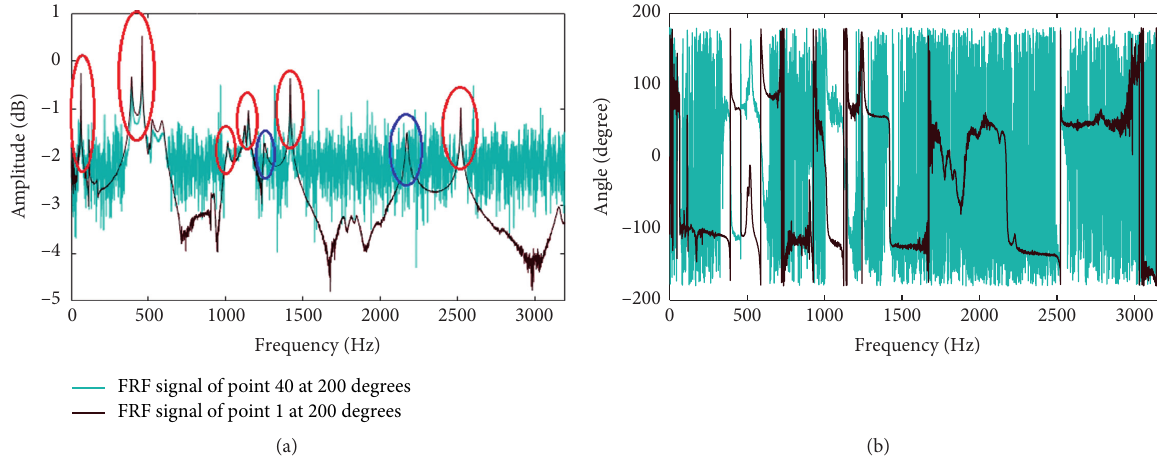
Figure 13: Overlay of the FRFs of Point 1 and Point 40. (a) Energy spectrum comparison. (b) Phase spectrum